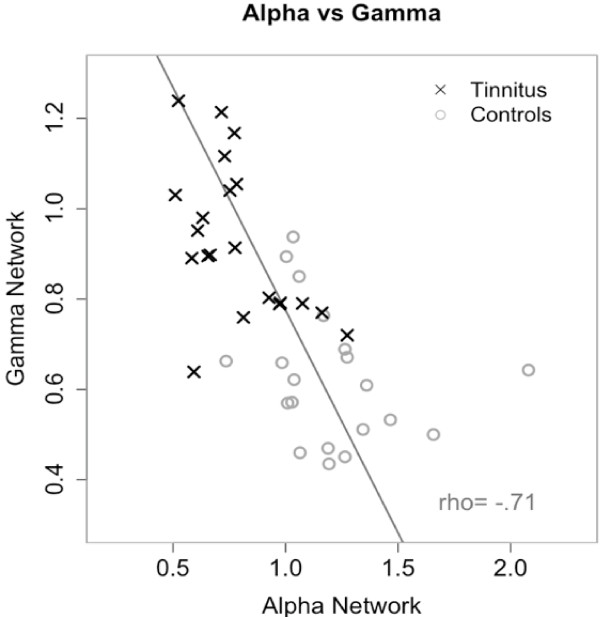
Negative relationship between the alpha and the gamma network. As an indicator for the strength of the alpha and the gamma network we calculated the sum of all phase locking values for both frequency bands. Decoupling of long-range alpha is associated with an increase of long-range gamma coupling. Individuals with tinnitus can be separated from controls with an accuracy of 83%.